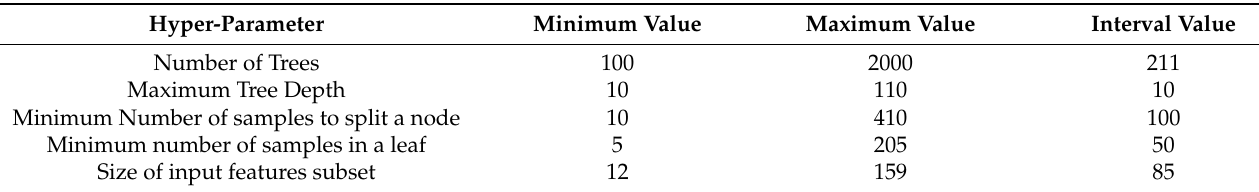
Table 3. The minimum, maximum, and interval values of the linear distribution function of the hyper-parameters from which 300 parameter setting were randomly selected.